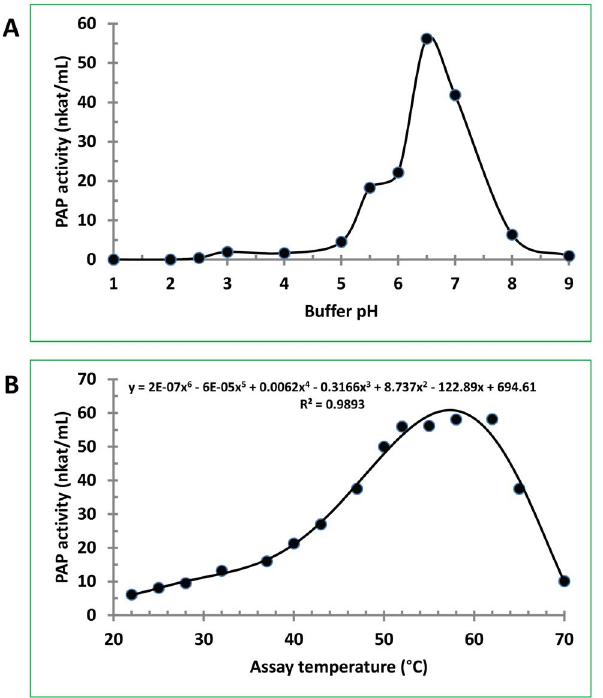
Figure 4. Effect of buffer pH and assay temperature on PAP activity. The assay was performed at 53 u C for 30 min using 5 m L of the PAP preparation with 500 m M DPA and 0.3 mM MgCl 2 . (A) pH profile of PAP enzyme catalyzing PtdOH. (B) Temperature profile of PAP enzyme catalyzing PtdOH. The data presented are the mean of 2 assays for each sample.